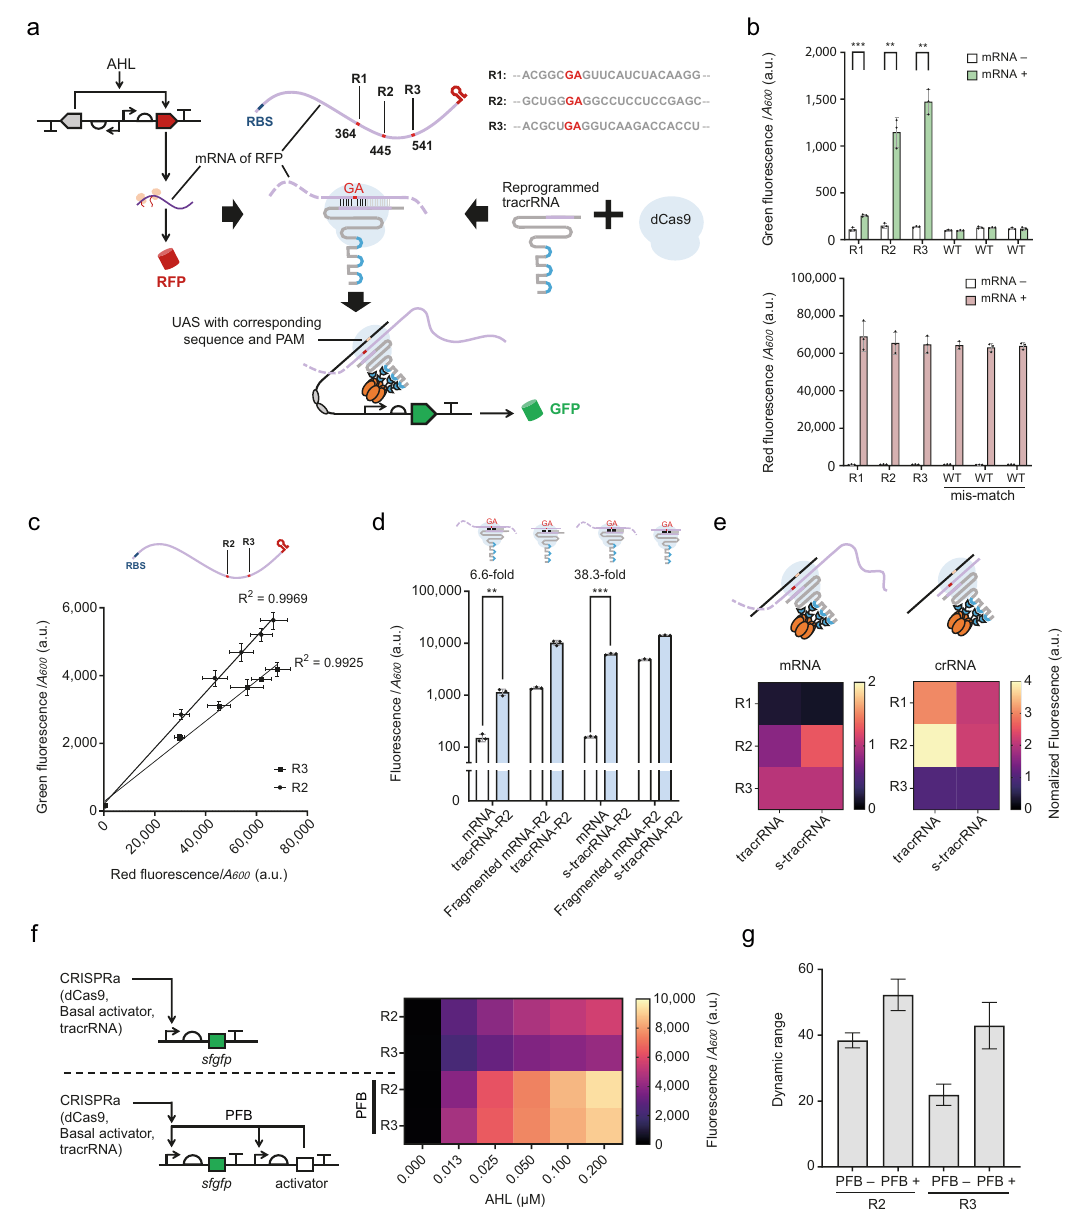
Fig. 3 Engineered tracrRNAs repurpose mRNAs into crRNAs and activate CRISPRa. a Schematic showing the design of the mRNA sensor. Three randomly selected RNA sites (red symbol) are represented. The sequences of three sites are shown in grey letters with GA site highlighted in red. b Green (top) and red fl uorescent outputs (bottom) of the mRNA-mediated CRISPRa. WT tracrRNA was used as a mis-matched control. Statistical difference was determined by a two-tailed t test: R1, p = 0.0004, t = 11.01, or by a Welch ’ s t test: R2, p = 0.0070, t = 10.91; R3, p = 0.0032, t = 17.13. Error bars, mean values ± s.d. ( n = 3). c Scatter plot shows the linear relationship between the expression levels of RFP and sfGFP. For R2, Equation: GF = 0.08230× RF + 216.5 ( GF : green fl uorescence, RF : red fl uorescence); the coef fi cient of determination (R 2 ) is 0.9969; p -value <0.0001. For R3, Equation: GF = 0.05937× RF + 282.8, R 2 = 0.9925; p -value < 0.0001. Error bars, mean values ± s.d. ( n = 3). d 5 ’ end truncation on tracrRNA improved CRISPR function. 5 ’ -end extended tracrRNA (tracrRNA) or 5 ’ -end truncated tracrRNA (s-tracrRNA) were employed. For the combination of mRNA and tracrRNA-R2, the same data were used as the data in b . Statistical difference was determined by a two-tailed Welch ’ s t test: mRNA + s-tracrRNA-R2, p = 0.0005, t = 43.63. Error bars, mean values ± s.d. ( n = 3). e The same sequence from mRNA fragment and whole mRNA resulted in altered CRISPR functions. The raw data obtained from R2 site are the same as that in d . In each group, the data are normalized by the CRISPRa output level of the sample with R3 site. f Diagram shows the CRISPRa circuit with a positive feedback loop (PFB), with the results on the right. The data of R2 and R3 sites without PFB is same as those in c . g Dynamic range calculated from f . Error bars, mean values ± s.d. ( n = 3). a.u., arbitrary units. p value summary: **** p value< 0.0001, 0.0001 < *** p value< 0.001, 0.001< ** p value< 0.01, 0.01 < * p value< 0.05, p value ≥ 0.05: ns. Source data are provided as a Source Data fi